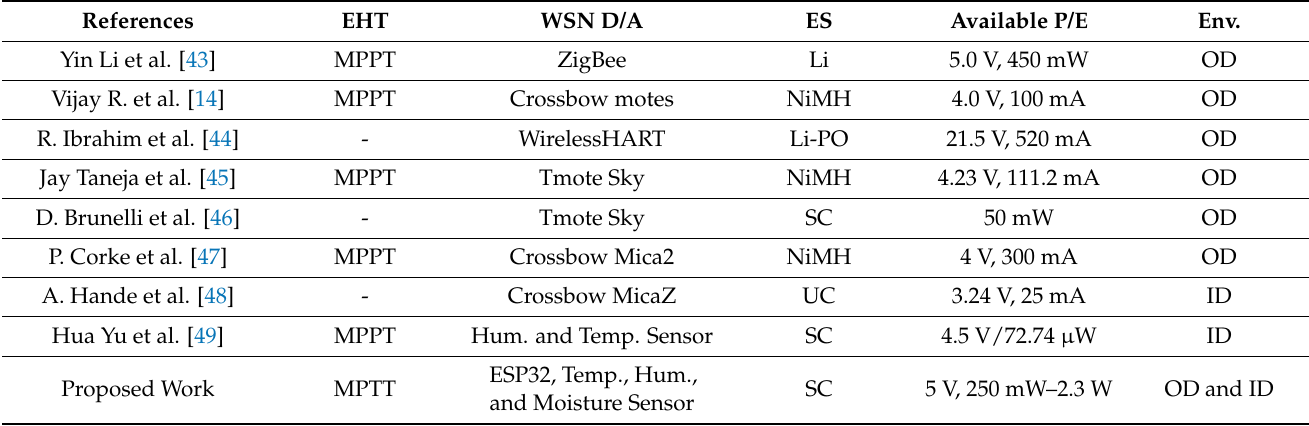
Figure 10. IoT features of the proposed prototype, ( a ) transmitting data to the webserver; ( b ) customized android dashboard on the smartphone. Table 3. Comparative analysis with published literature on solar integrated energy harvesting systems for wireless sensor networks vs. the proposed